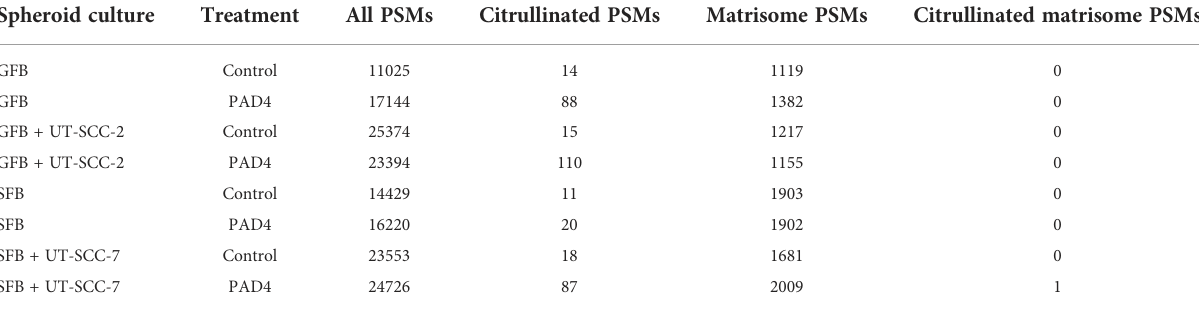
TABLE 4 Number of spectra matching to citrullinated or to all peptides obtained from the mass spectrometric analysis of spheroid co-cultures of cutaneous squamous cancer cell lines and human fi broblasts with or without PAD4 treatment before lysis. Spheroid